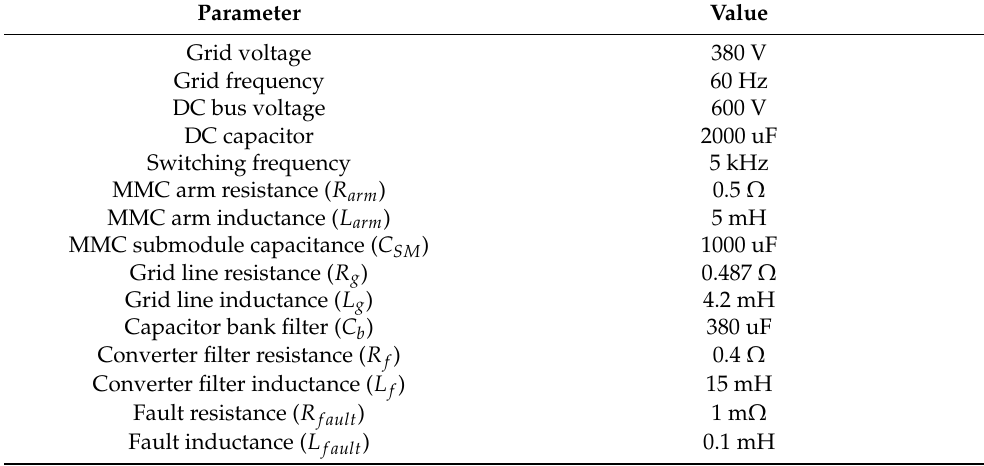
Table 4. System parameters.